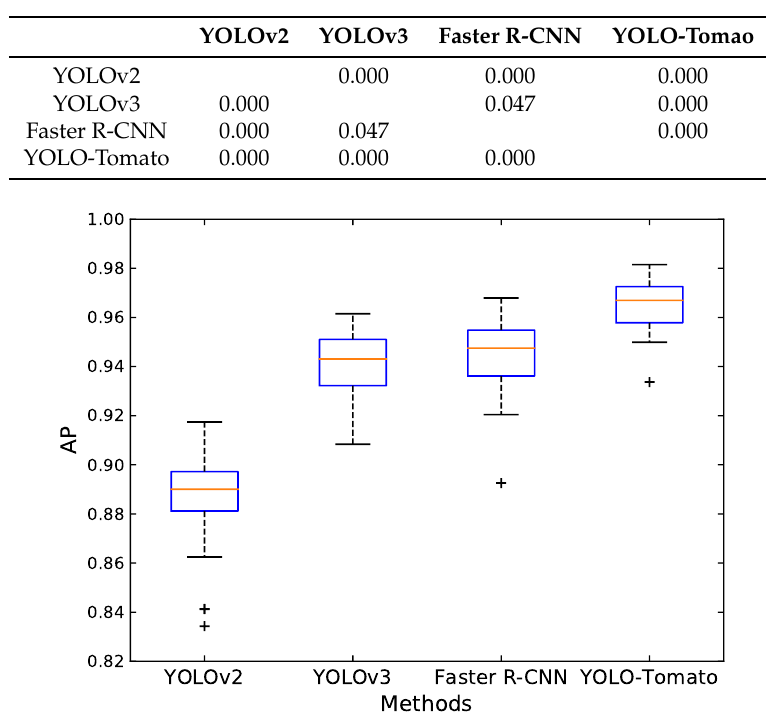
Table 6. The p -value obtained by the Wilcoxon signed-rank test for each pair of detection methods.